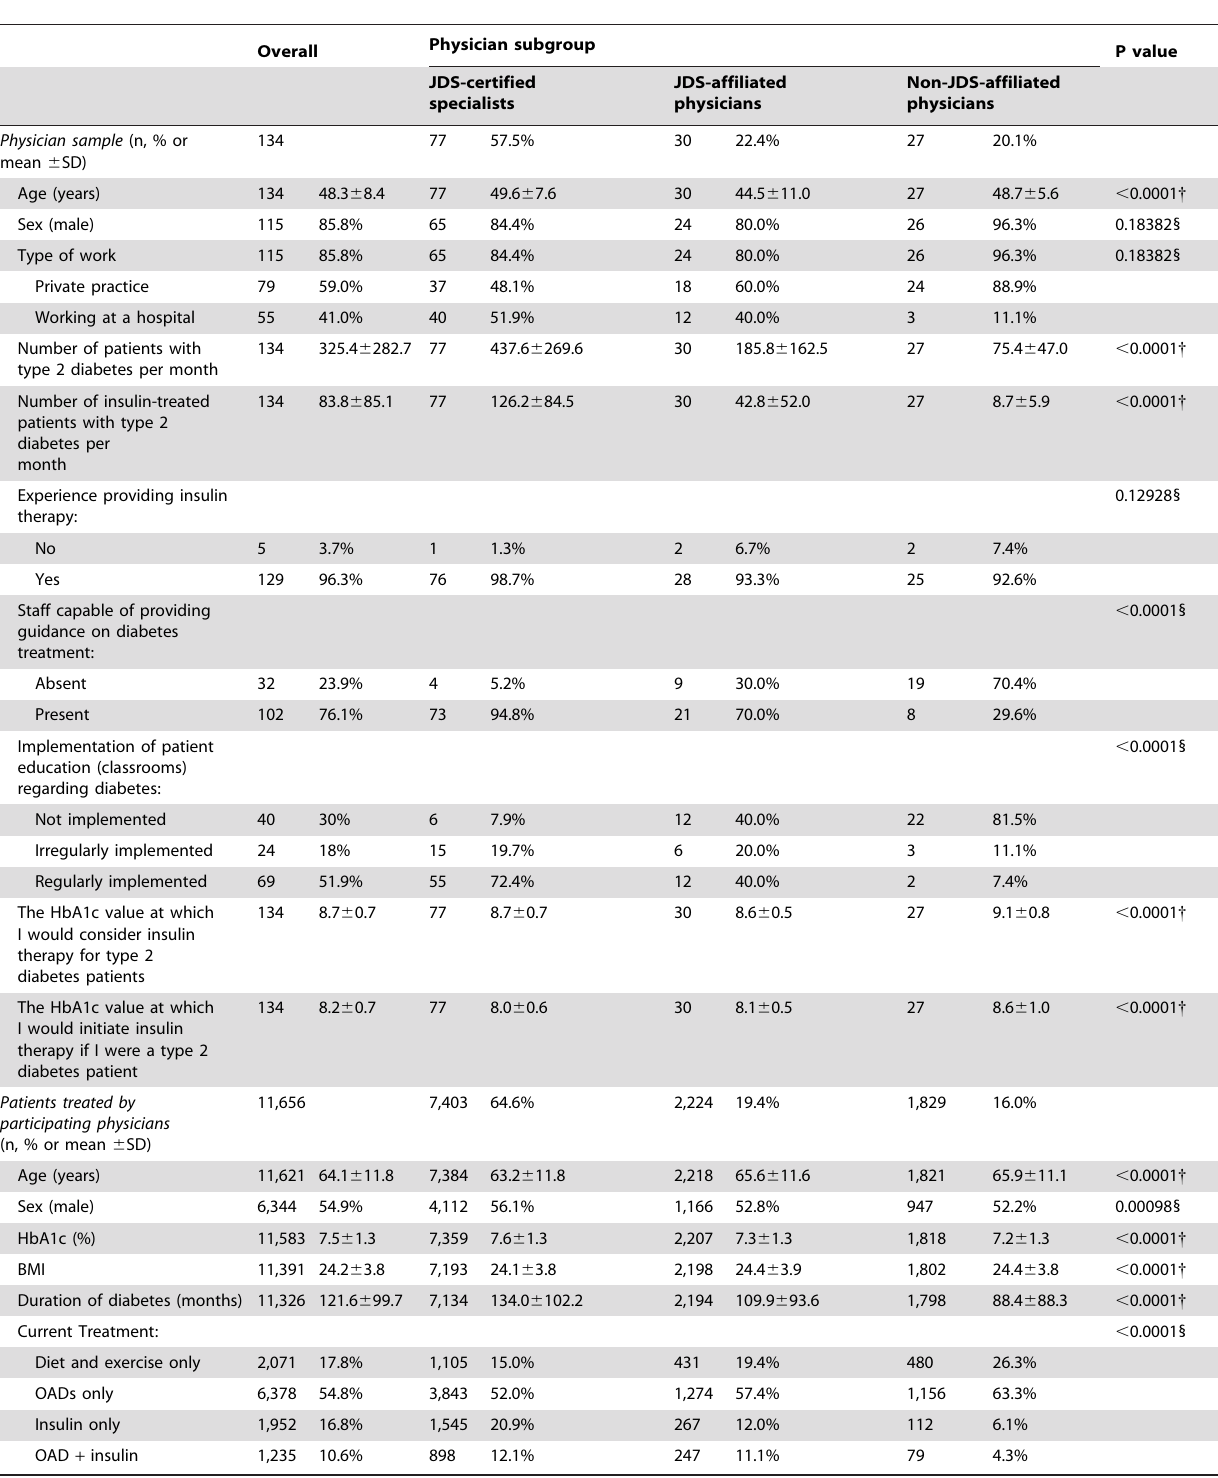
Table 1. Background information of participating physicians and their patients.